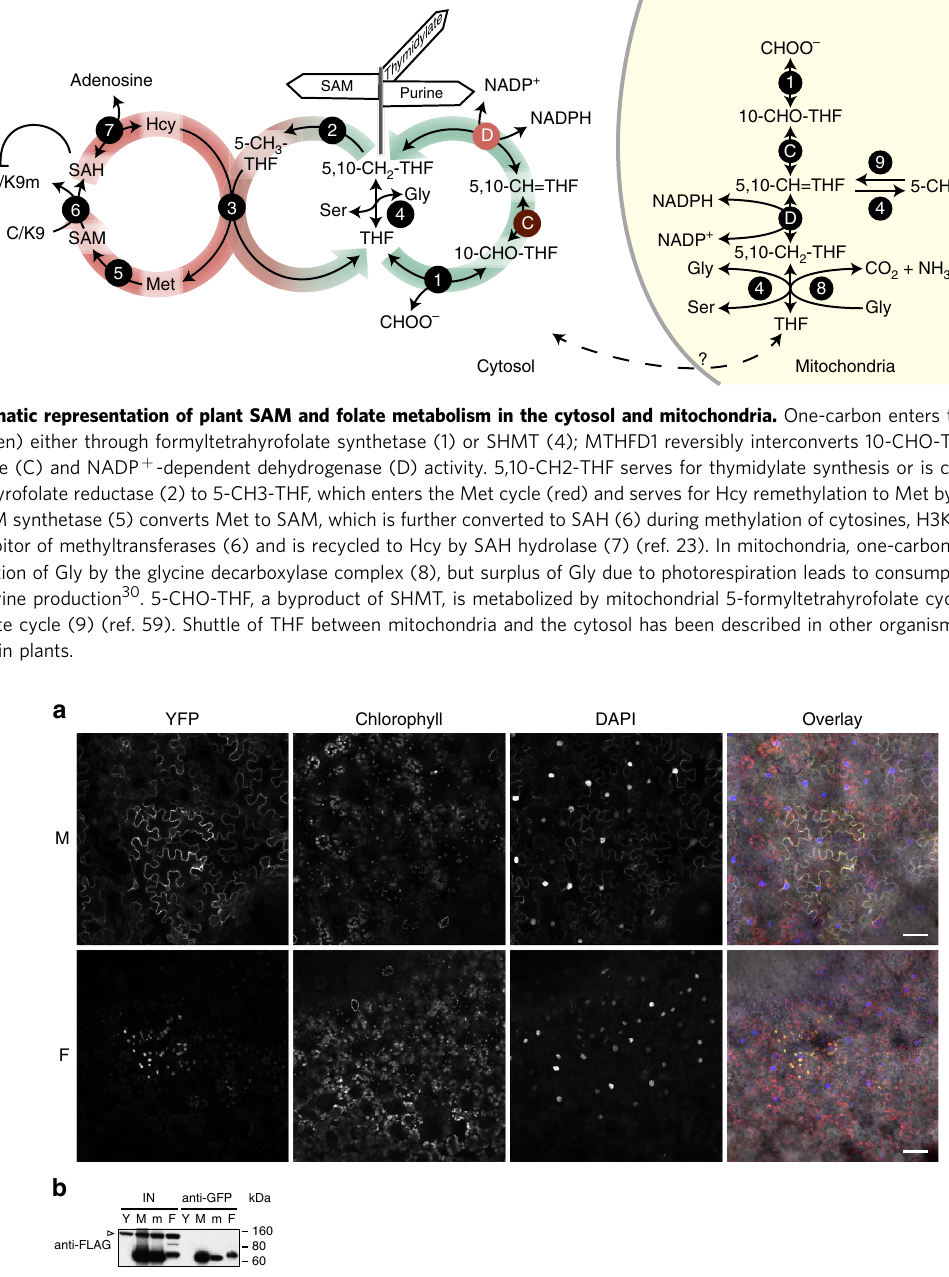
Figure 6 | Cytoplasmic localization of MTHFD1-YPET-3xFLAG. ( a ) Confocal micrographs of MTHFD1-YPET-3xFLAG (M) and FOLD4-YPET-3xFLAG (F) transiently expressed in N. benthamiana . Excitation ( l , nm)/filters ( l , nm): YFP ¼ 514/519–559, chlorophyll ¼ 488/630–730, DAPI ¼ 405/409–530, and fluorescence overlay with bright field. Scale bars, 50 m m. ( b ) Western blot using anti-FLAG antibody against anti-GFP-immunopurified extracts from N . benthamiana (IN) transiently expressing free YFP (Y), MTHFD1-YPET-3xFLAG (M), MTHFD1_R175Q-YPET-3xFLAG (m), or FOLD4-YPET-3xFLAG (F). Arrowhead indicates unspecific binding of anti-FLAG (shown as loading